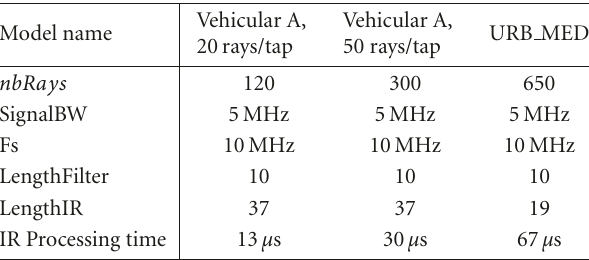
Table 1: Impulse response processing